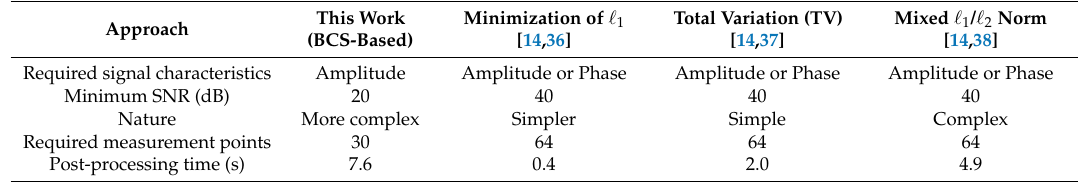
Table 1. Comparison between Bayesian compressive sensing (BCS)-based approach and previous compressive sensing techniques. SNR—signal-to-noise